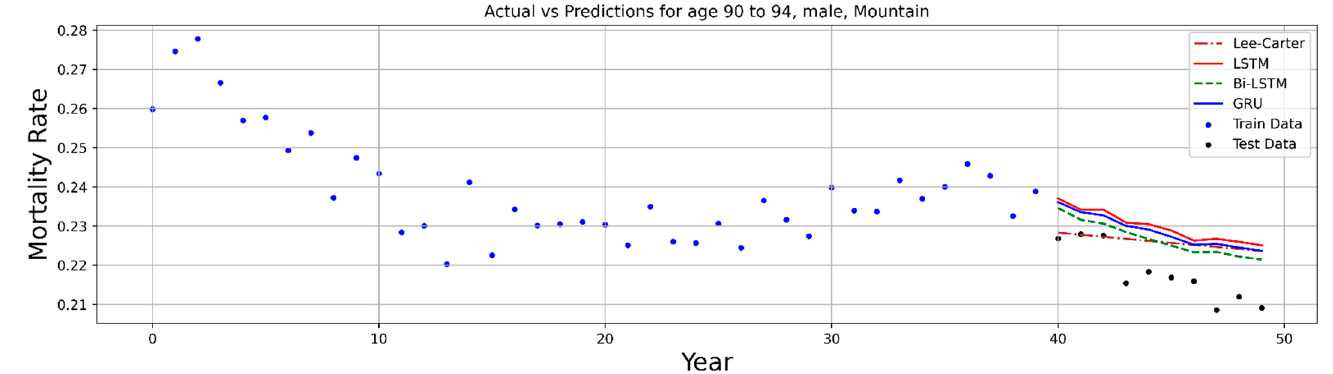
Figure 7. The life expectancy of models in the age group 90–94, Mountain male population.